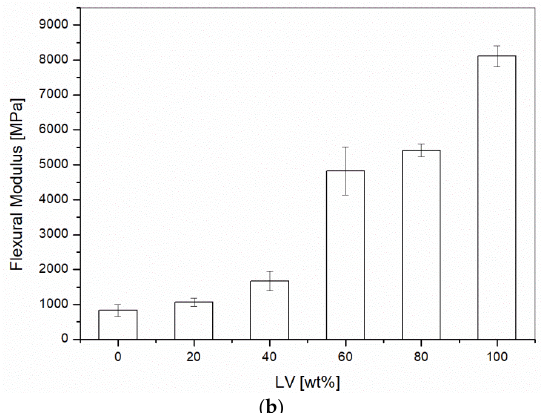
Figure 1. Flexural testing on PP/Liquid Wood as a function of the Liquid Wood (LV) content: ( a ) Flexural strength; ( b ) Flexural modulus.